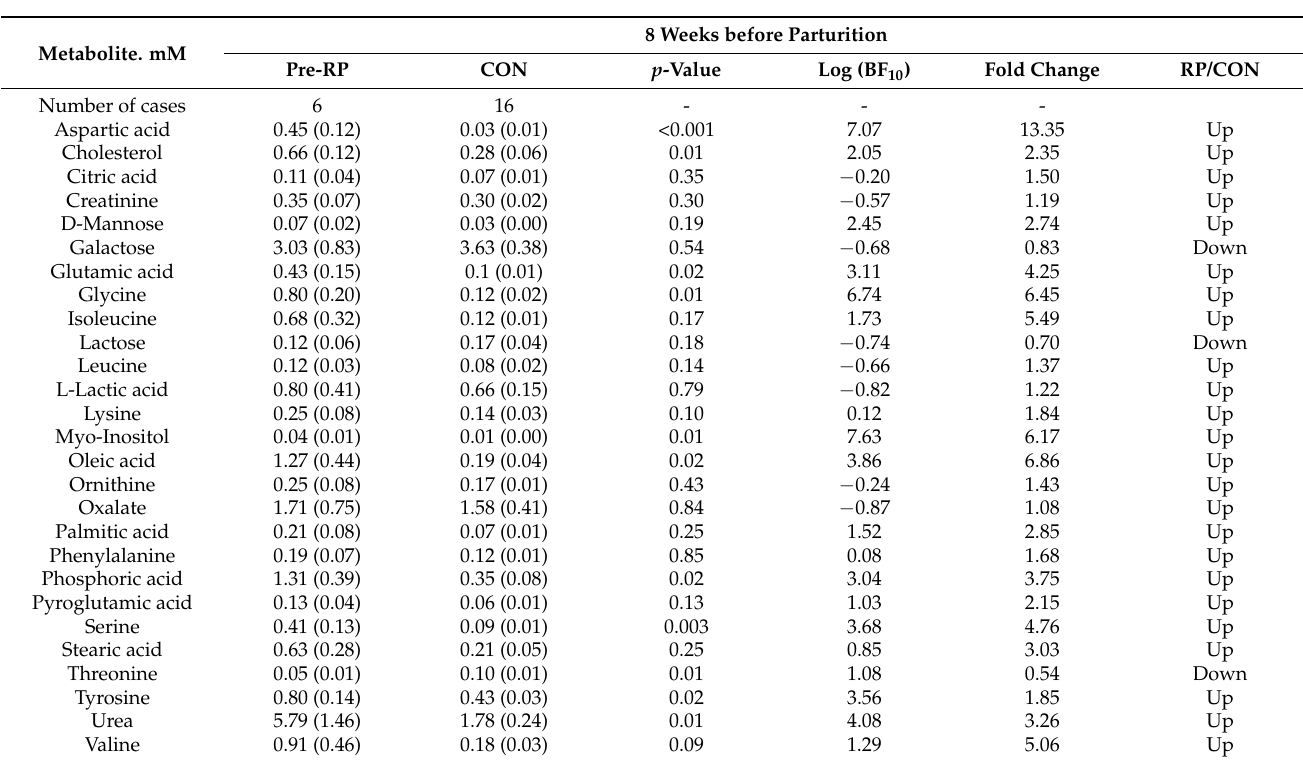
Table 1. Concentrations of serum metabolites [mean(SD)] in healthy controls (CON) and pre-retained placenta (Pre-RP) cows at − 8 weeks pre-partum as determined by GC/MS.